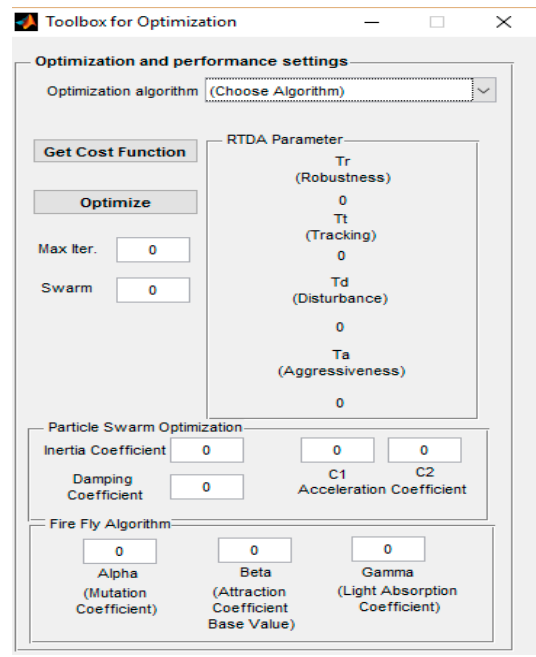
Figure 6. GUI for the RTD-A controller parameter optimization tool.